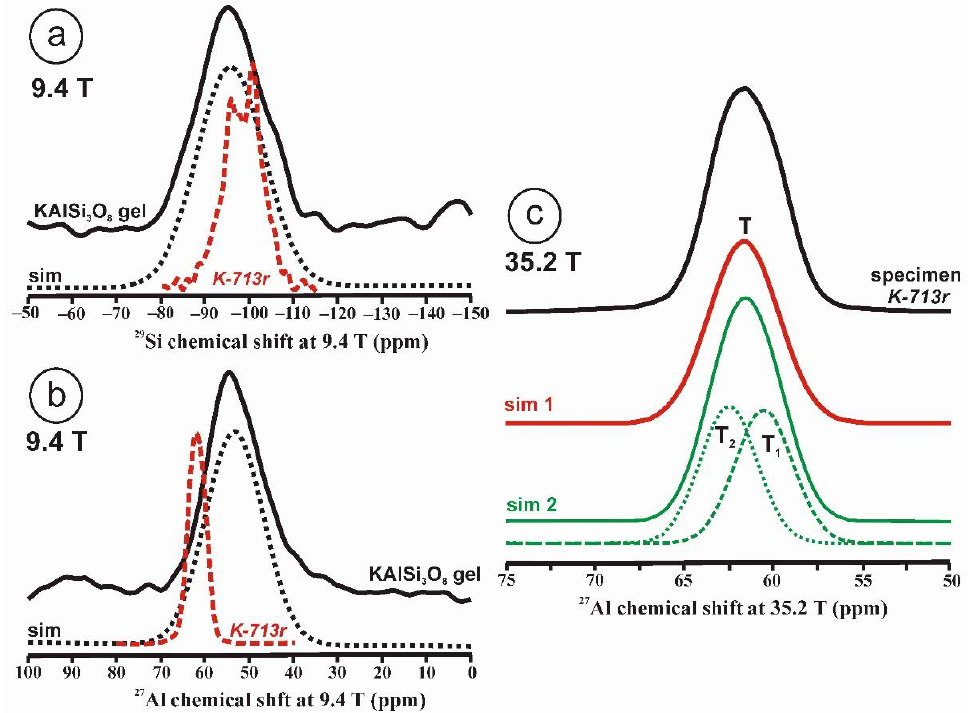
Figure 1. The 29 Si and 27 Al MAS NMR spectra of the KAlSi 3 O 8 gel in comparison with those in sanidine. ( a ) The 29 Si MAS NMR spectrum at 9.4 T and the simulation by a Gaussian curve with c.g. ~ − 96 ppm and lw = 18 ppm of sample KAlSi 3 O 8 gel, with a profile in dashed curve of the 29 Si spectrum at 9.4 T of sanidine in specimen K-713r in red. ( b ) The 27 Al MAS NMR spectrum at 9.4 T and the simulation with a Gaussian curve with c.g. = 53.5 ppm and lw = 15.4 ppm, of sample KAlSi 3 O 8 gel, with a profile in dashed curve of the 27 Al spectrum of sanidine in specimen K-714r, ( c ) The 27 Al MAS NMR spectrum at 35.2 T of specimen K-713-r, the spectrum can be simulated with a single Gaussian curve (sim 1 in red) at c.g. = 61.6 ppm and lw = 4.7 ppm, but also with two Gaussian curves (sim 2 in green) at c.g. = 62.5 ppm and lw = 3.8 ppm and area 50.1% for T 2 site, and at c.g. = 60.6 ppm and lw = 3.8 ppm and area 49.9 % for T 1 site. The 27 Al MAS NMR spectra at 35.2 T were obtained using a 3.2 mm rotor, υ r = 12.5 kHz, π/2 at 20.4 μs and 218 W; for the experimental conditions of the 29 Si and 27 Al MAS NMR at 9.4 T see ref [4].